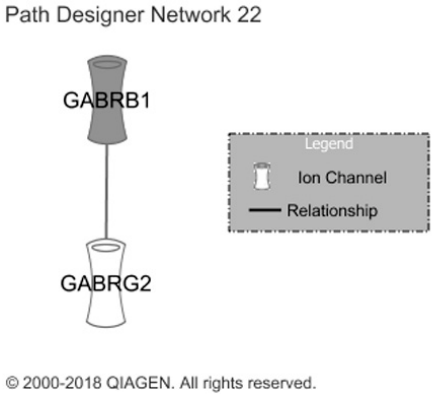
Figure 5. Representation of neurological pathways. The filled icons represent genes with increased expression, indicative of the association with neurological ADR manifestations.